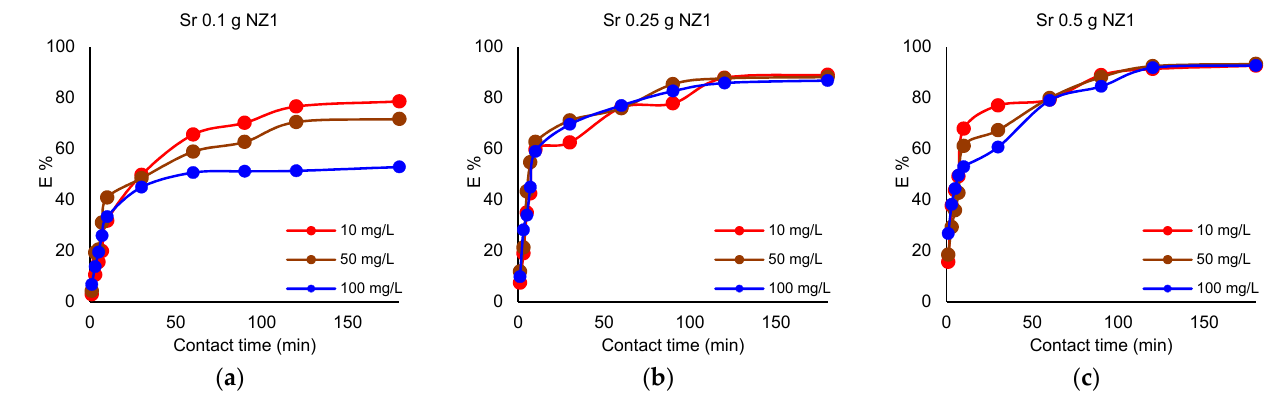
Figure 1. Removal e ffi ciency (%) of Cs + by di ff erent NZ1 quantities; ( a ) 0.1 g, ( b ) 0.25 g, ( c ) 0.5 g; V = 50 mL; 200 rpm; 22 ± 2 °C, 180 min.